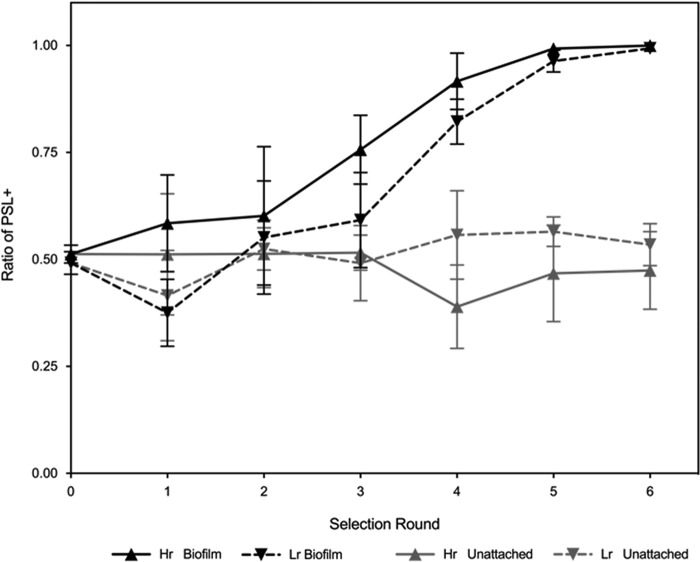
PSL production is favored in high- and low-relatedness treatments in biofilms. PSL+ cells had a selective advantage under conditions promoting biofilm formation (black) (F1,20 =542.7, P < 0.0001; n = 6). However, this observation was not reciprocated under unattached conditions (gray). The concurrent loss of PSL− cells from both low-related and high-related biofilm populations through subsequent selection rounds suggested there is a strong selection toward PSL+ strains (under biofilm-promoting conditions only), as PSL− strains were unable to cheat on PSL+ strains.